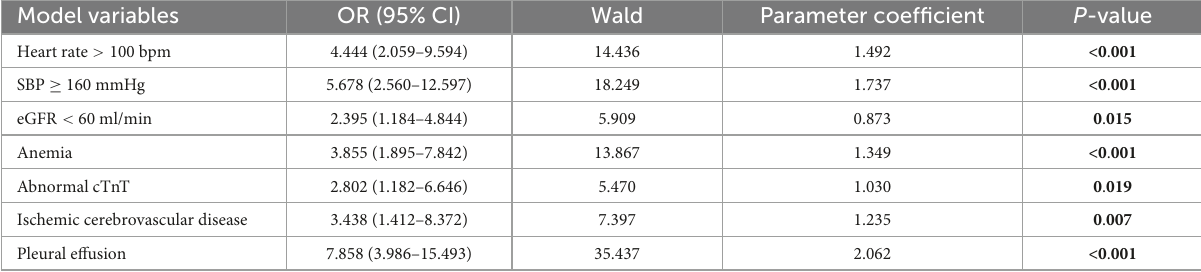
TABLE 5 Multivariate logistic regression analysis of factors possibly associated with in-hospital mortality in tpatients with Stanford type B aortic dissection. Model